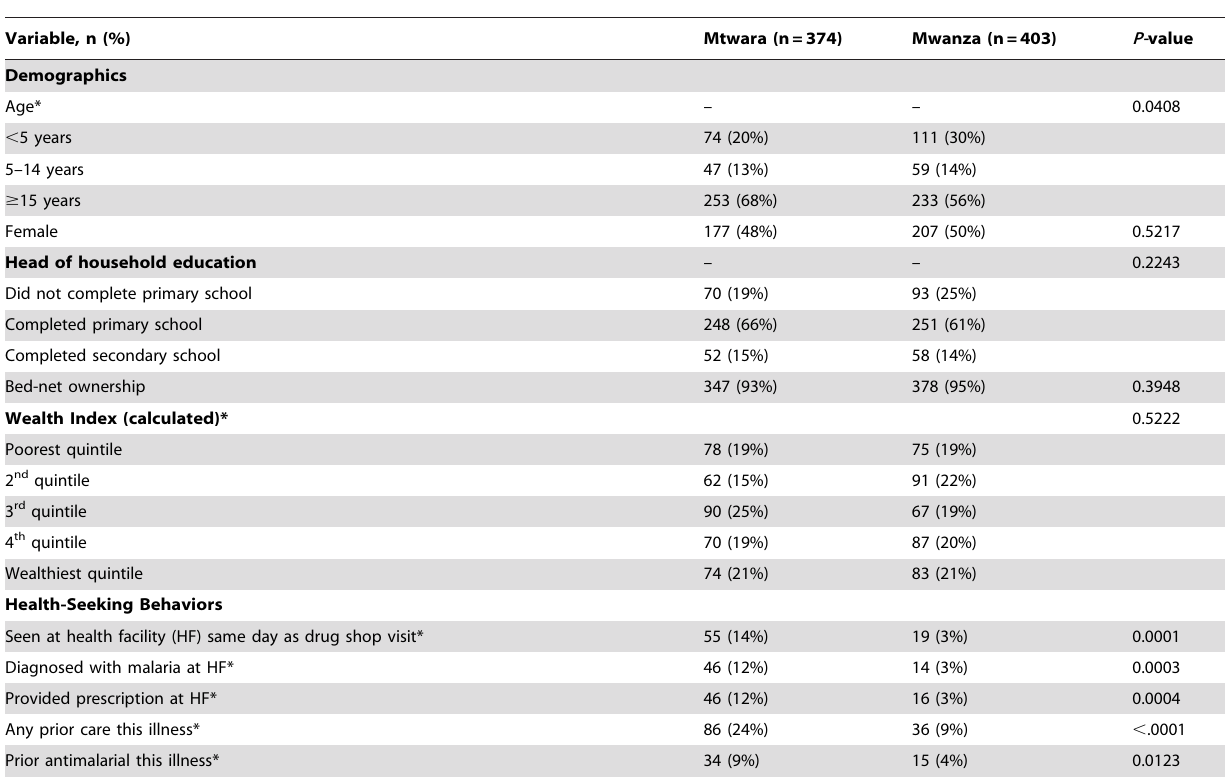
Table 2. Client Demographics and Health-Seeking Behaviors Stratified by